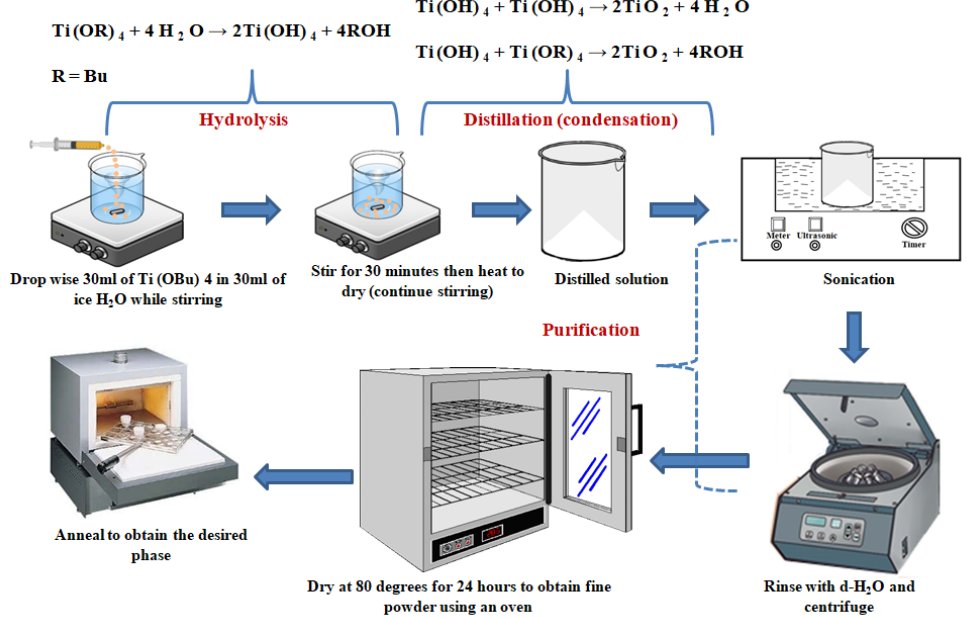
Figure 3. Schematic illustration of synthesising rutile-TiO2 NPs.